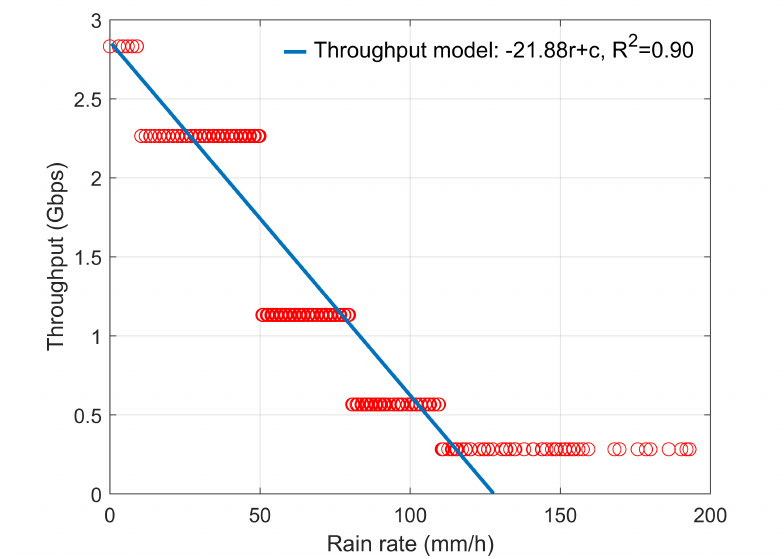
Figure 8. Variation of throughput with rain rate at full-duplex wireless back-haul E-band link along 300